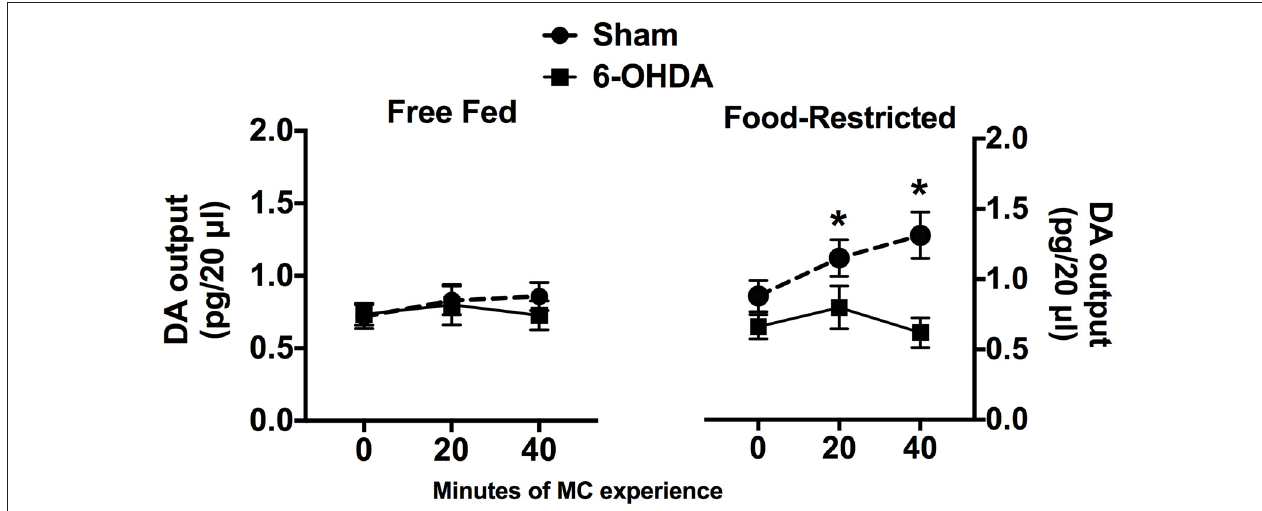
Shell ( Figure 1 , left). Instead, a significant interaction between factors was revealed for data collected in FR mice ( F ( 2,20 ) =